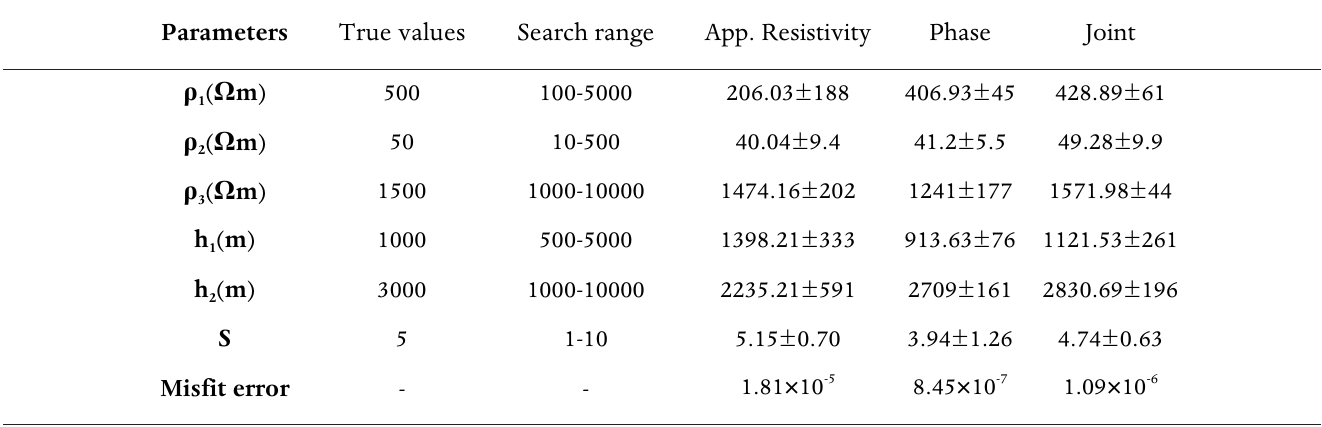
Table 2. Model 1: inversion results with optimization of static